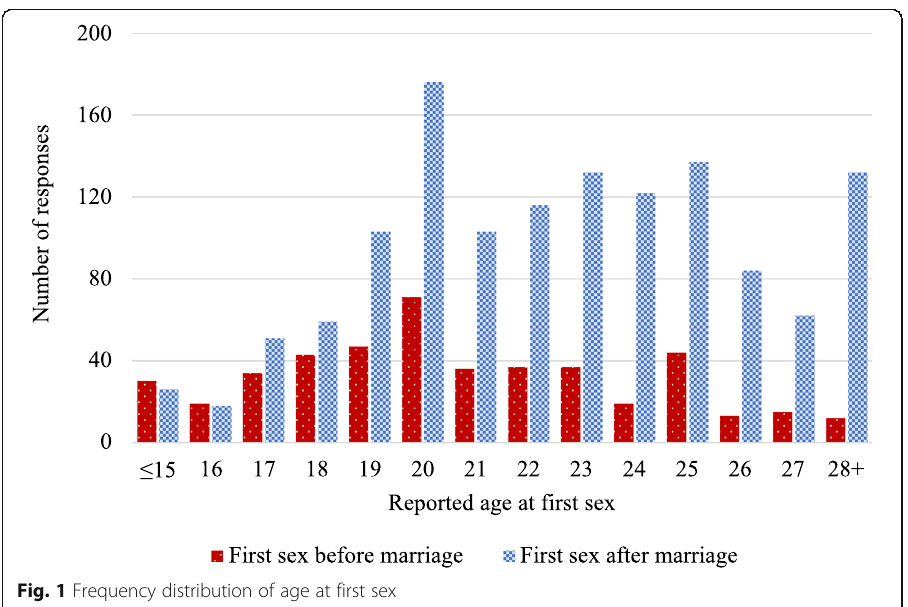
Fig. 1 Frequency distribution of age at first sex Source: The 2010 Greater Jakarta Transition to Adulthood